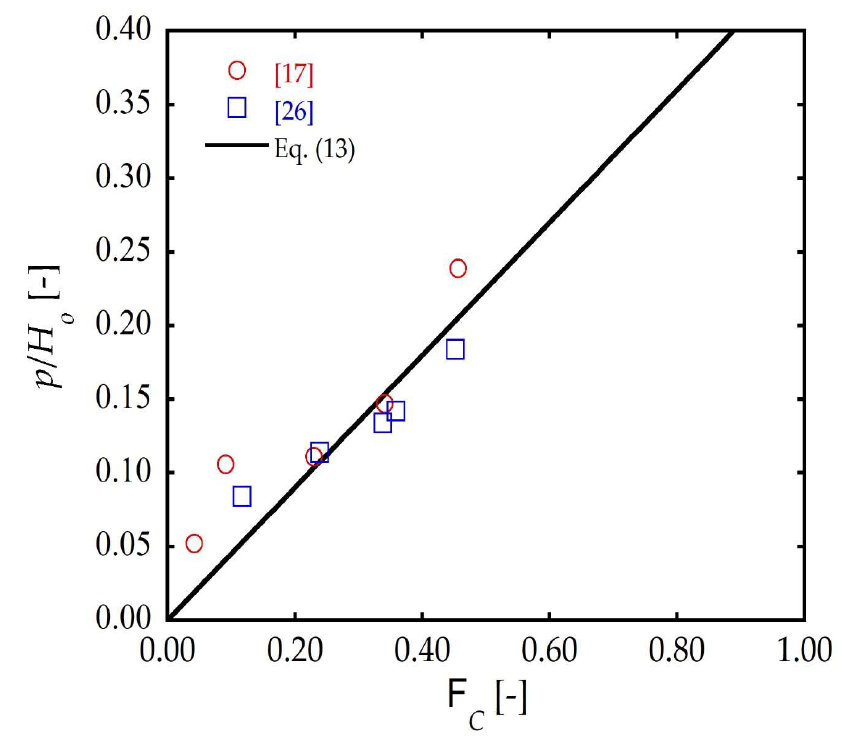
Figure 6. Maximum relative invert pressure p / H o against the capacity Froude number F C